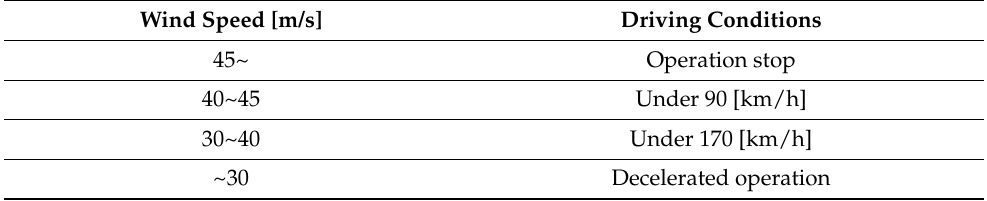
Table 7. The regulations on driving conditions according to wind speeds.